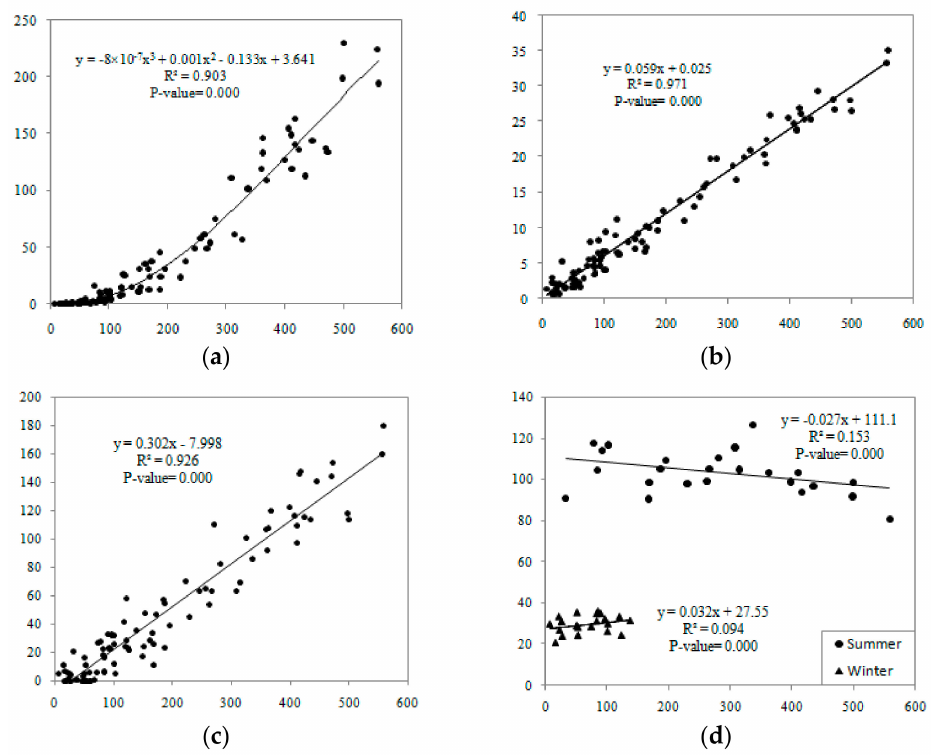
Figure 11. Regression analysis results for the hydrological elements and precipitation. ( a ) Surface flow and precipitation; ( b ) Lateral runoff and precipitation; ( c ) Groundwater discharge and precipitation; ( d ) ET and